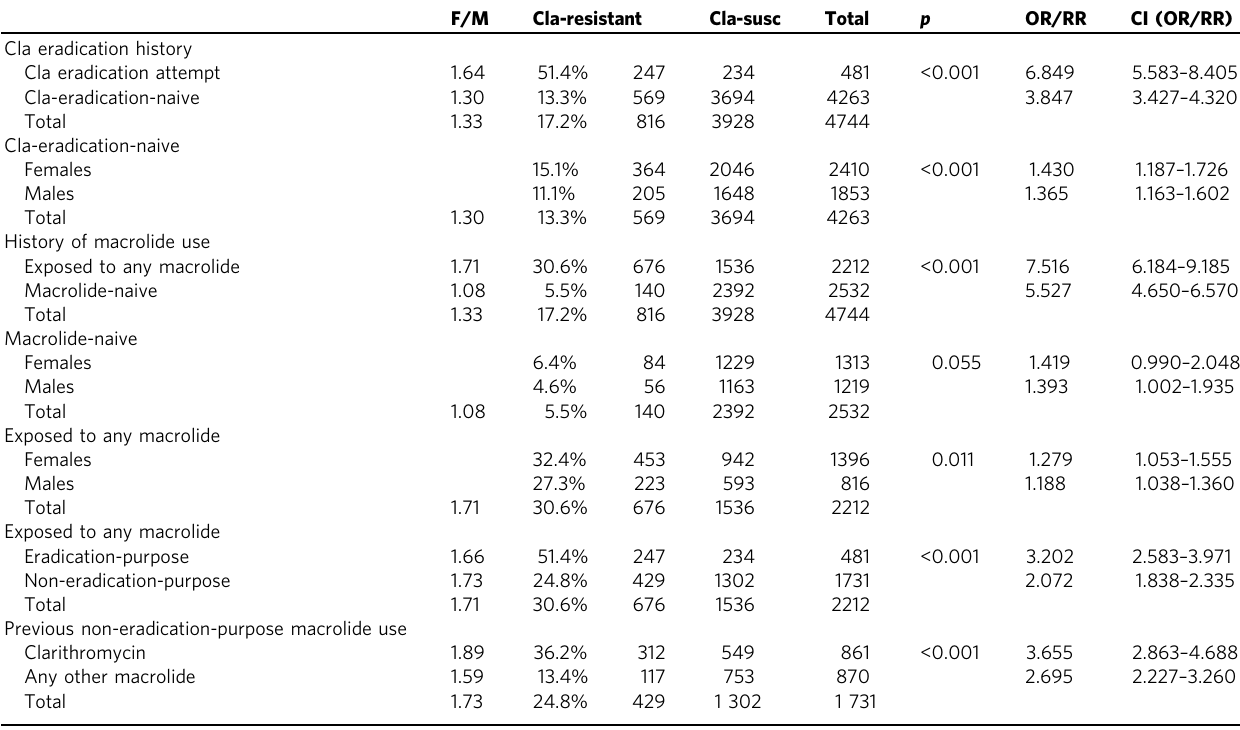
Table 2 Clarithromycin resistance rates of H. pylori -infected individuals according to prior eradication therapy and use of